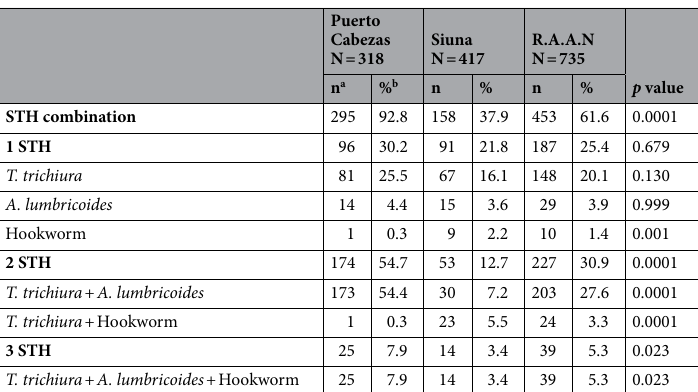
Puerto Cabezas N = 318